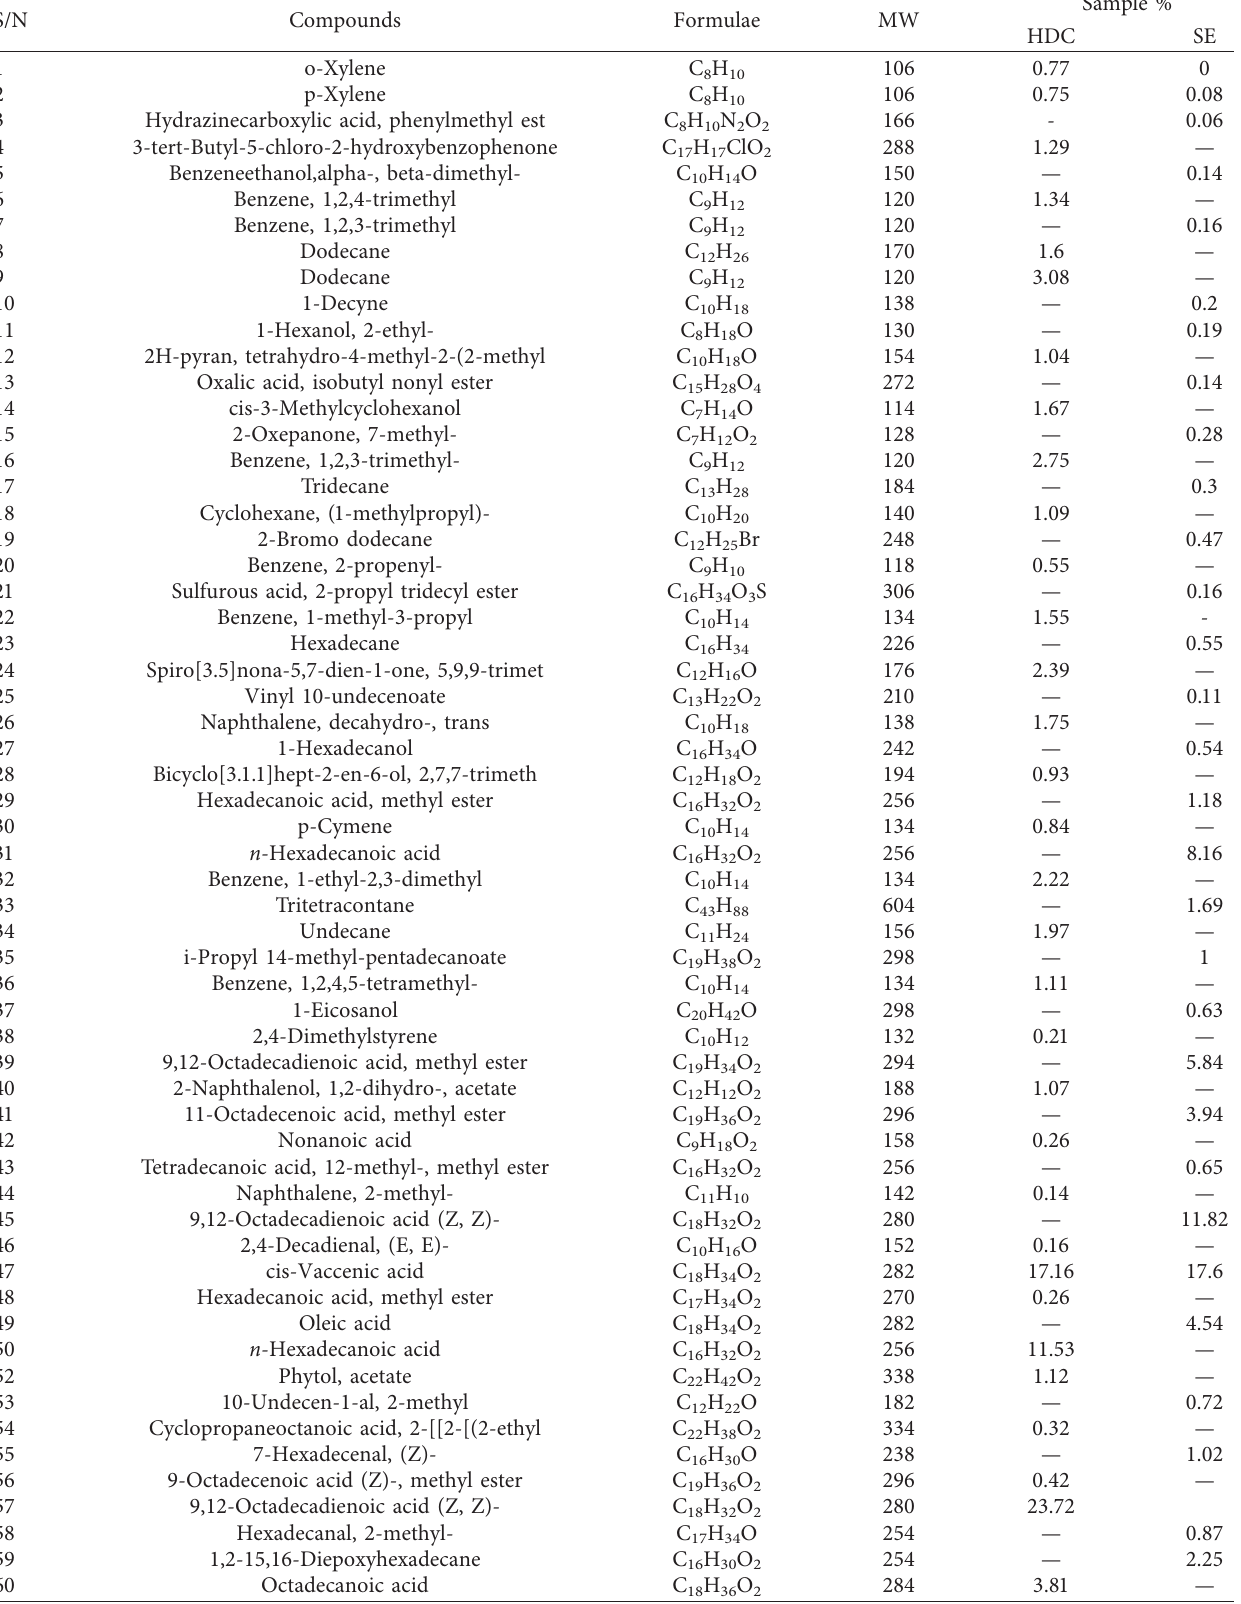
Table 2: Gas chromatography-mass spectrometry result of the EOS of tamarind seed obtained from the two